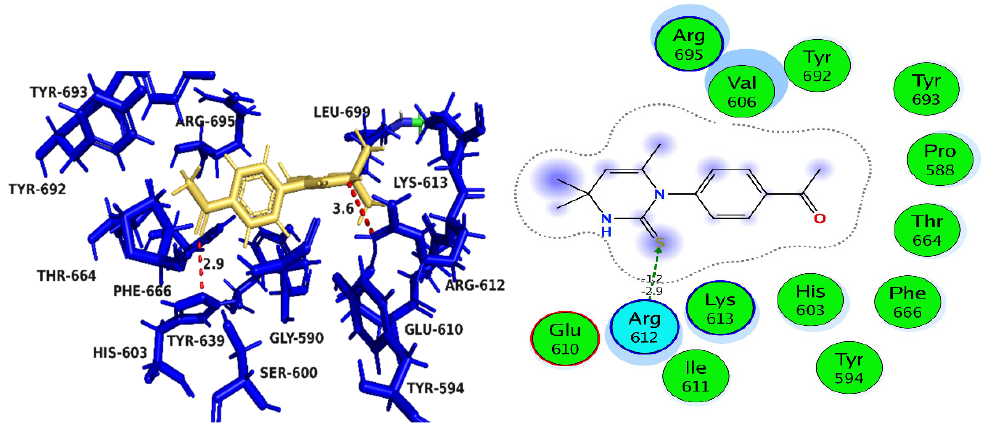
Figure 11. Most probable 2D and 3D interactions of compound 4 within activation loop of RNR protein .